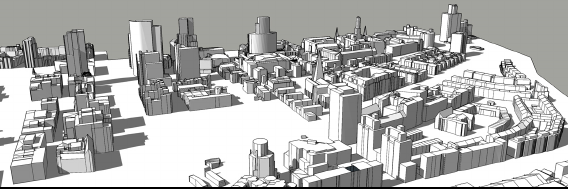
Figure 4. Virtual city model of Rotterdam (part) in cityGML LOD2, by: